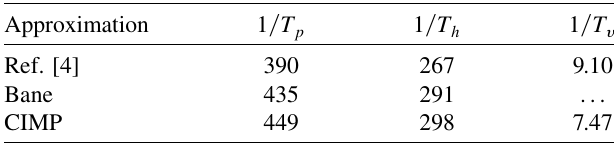
TABLE II. Comparison of the Bane and CIMP high energy approximations to the more complete theory of Ref. [4] for the ATF prototype damping ring. Quantities are in sec (cid:10) 1 . Approximation